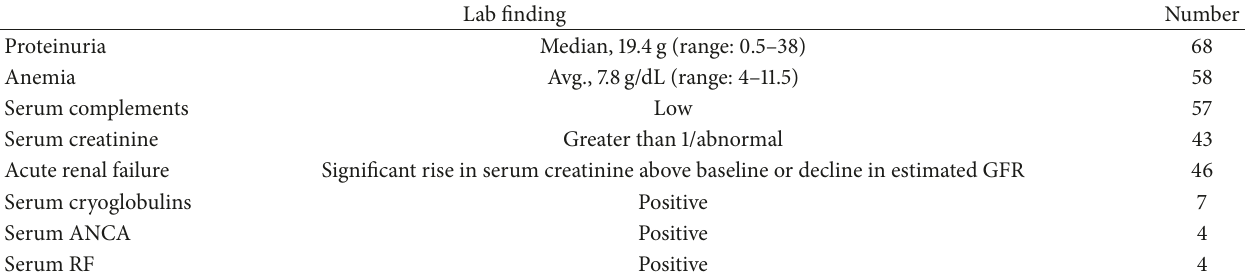
Table 4: Lab findings in shunt nephritis.